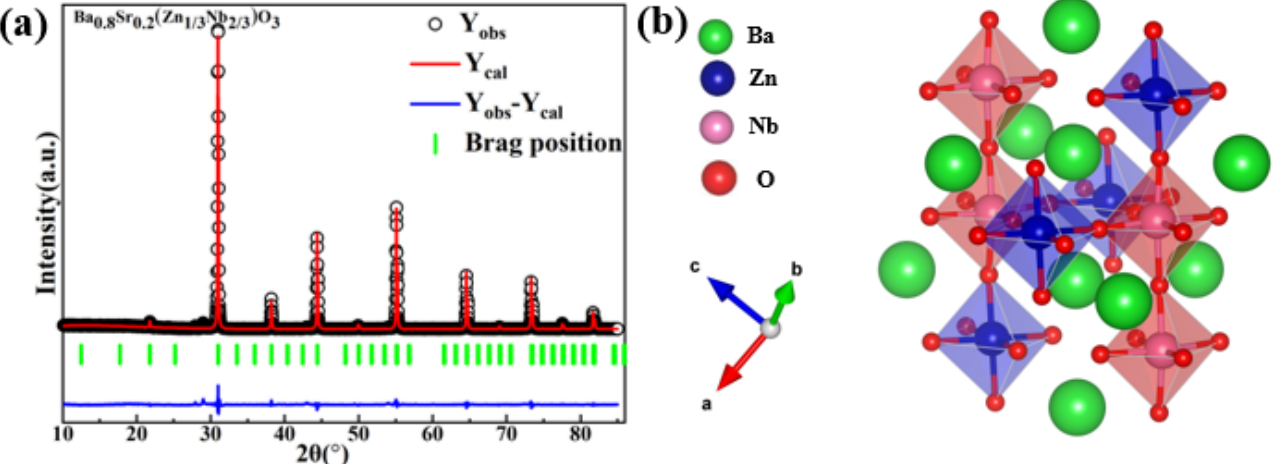
Figure 3. ( a ) The refinement plot of Ba 1 − x Sr x (Zn 1/3 Nb 2/3 )O 3 ( x = 0.2) ceramics (R wp = 9.61%, R p = 6.1%, and χ 2 = 2.88); ( b ) The crystal structure patterns of Ba 1 − x Sr x (Zn 1/3 Nb 2/3 )O 3 ( x = 0.2) ceramics.